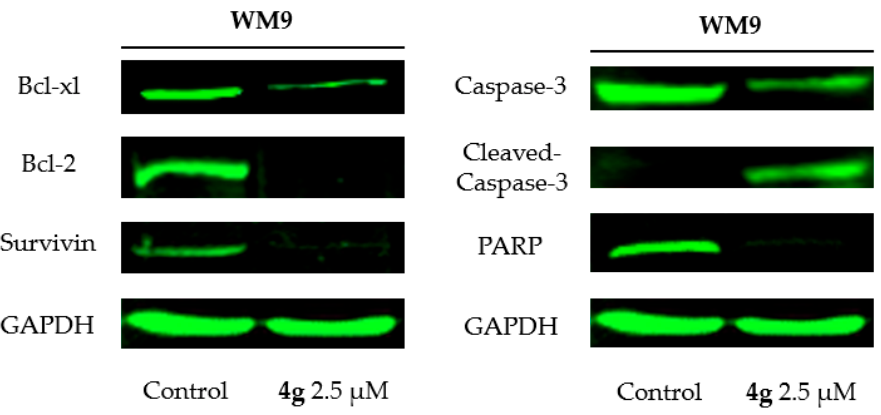
Figure 3. Fangchinoline derivative 4g affects the protein levels of the apoptotic genes in WM9 cell line. Western blots using the indicated antibodies revealed that 4g treatment activated the apoptosis pathway in WM9 cell line. WM9 cells were treated with 2.5 µM 4g for 24 h.